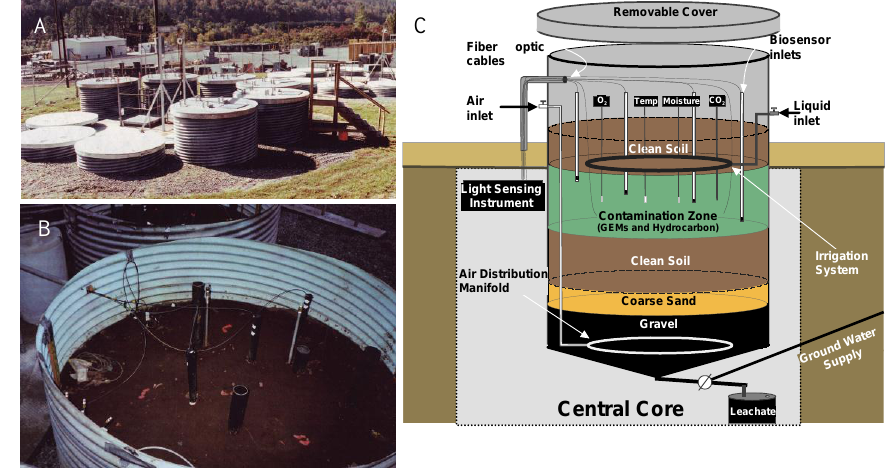
Figure 6. Scheme of the lysimeter facility used in long-term field biodegradation experiment ( A ) The lysimeter facility consisted of six replicate and control soil ecosystems; ( B ) Inside view of one of the six soil packed lysimeters; ( C ) Representative schematic of one of the 4 m deep  2.5 m diameter lysimeters used for the release of P. fluorescens